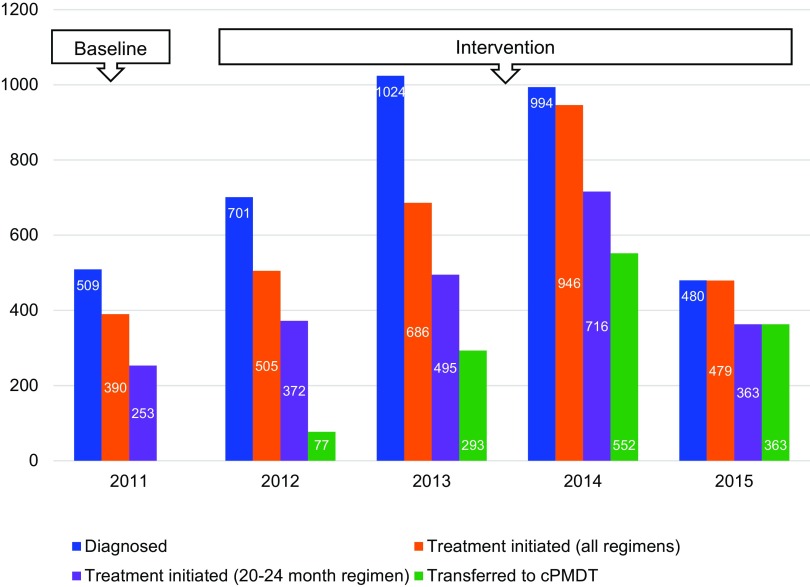
Trends in Diagnosis and Treatment Initiation, Bangladesh, 2011–2015Abbreviation: cPMDT, community-based programmatic management of drug-resistant tuberculosis.